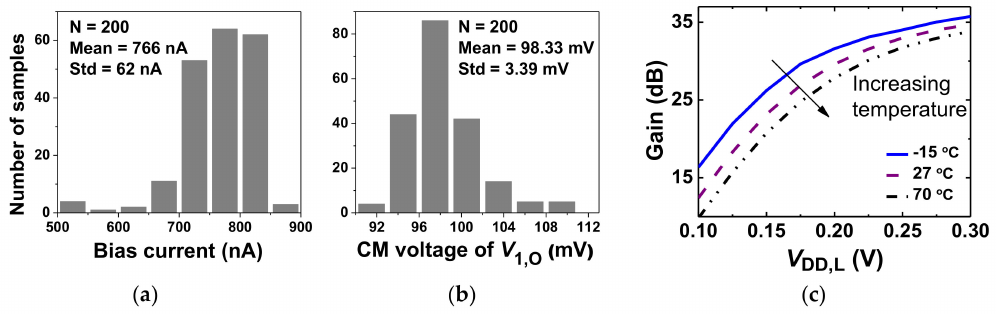
Figure 5. Monte Carlo simulation results for the ( a ) bias current, ( b ) output common-mode (CM) voltage of the squeezed-inverter (SQI) stage. ( c ) simulated gain of the SQI stage depending on V DD,L and